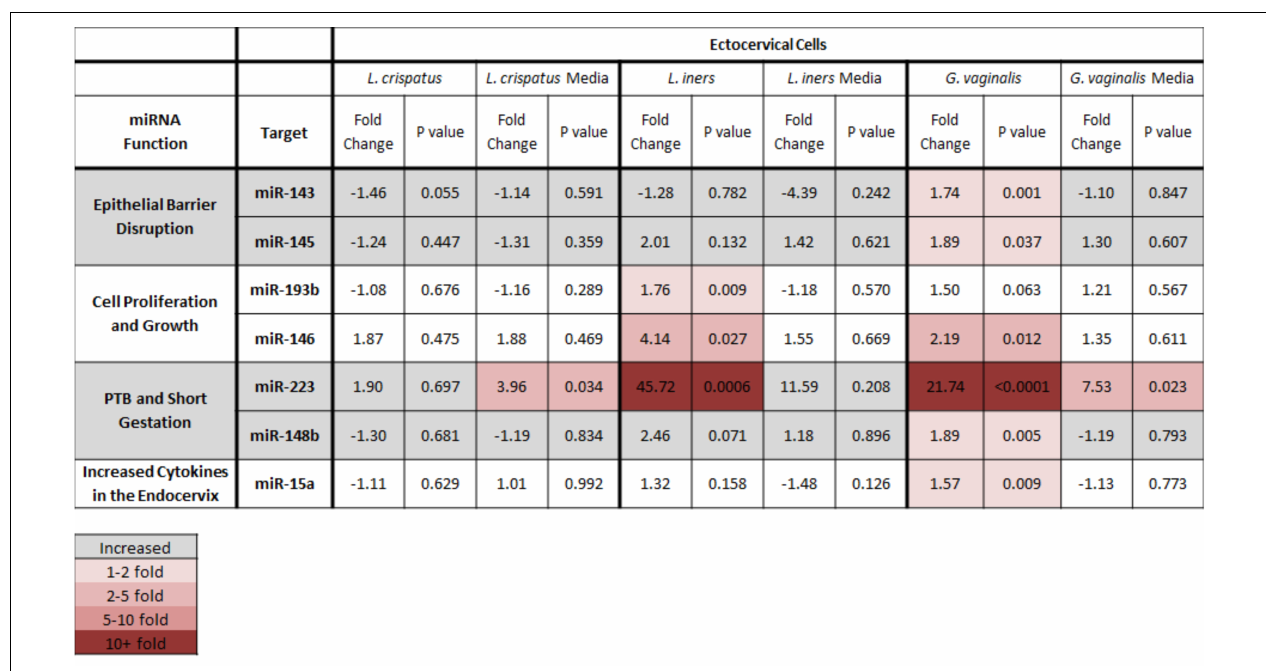
FIGURE 4 | Lactobacillus crispatus , L. iners , and G. vaginalis bacteria-free supernatants differentially alter the miRNA expression profile of ectocervical cells. miRNA expression was measured by QPCR in ectocervical cells after exposure to L. crispatus , L. iners , and G. vaginalis bacteria-free supernatants (10% v/v) for 48 h. Bacterial growth media alone acted as a negative control for the three bacteria-free supernatants tested. The (cid:49)(cid:49) CT method was used for relative expression quantification using the endogenous reference gene RNU6B. Modified heat map shows fold change versus control (non-treated cells) and corresponding p -values. Color distinguishes level of fold change. Values are mean ±